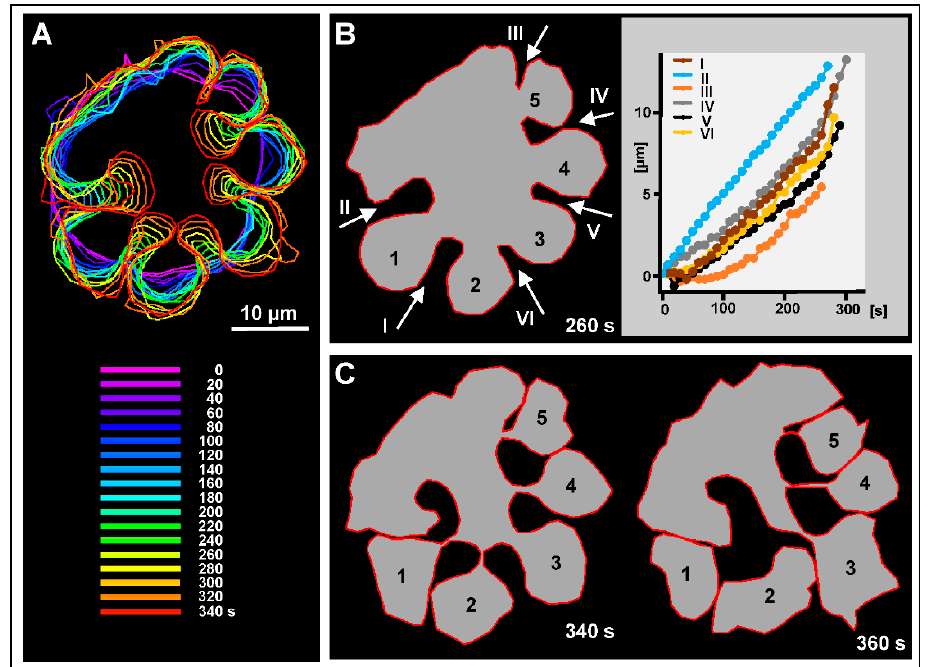
Figure 4. Progression of cleavage furrows in the multinucleate wild-type cell of Figure 3. ( A ) Color-coded cell boundaries within the 0 to 340 s time span derived from the confocal fluorescence images of myosin-II. ( B ) Left panel: cell boundary at the 260 s time point, showing unilateral cleavage furrows I to VI and incipient daughter cells 1 to 5. Right panel: progression of the six cleavage furrows, measured in the direction indicated by the arrows in the left panel. ( C ) Comparison of cell boundaries at the 340 s and 360 s time points. Within the time span of 20 s, the daughter cells 1 and 2 became disconnected, while separation of the incipient daughter cells 3 to 5 proceeded. In all these cases, abscission occurred obliquely to the initial furrowing. The drawings in ( B ) and ( C ) show the cell shapes in the confocal plane, with additional information on connectivity gathered from the bright-field images.